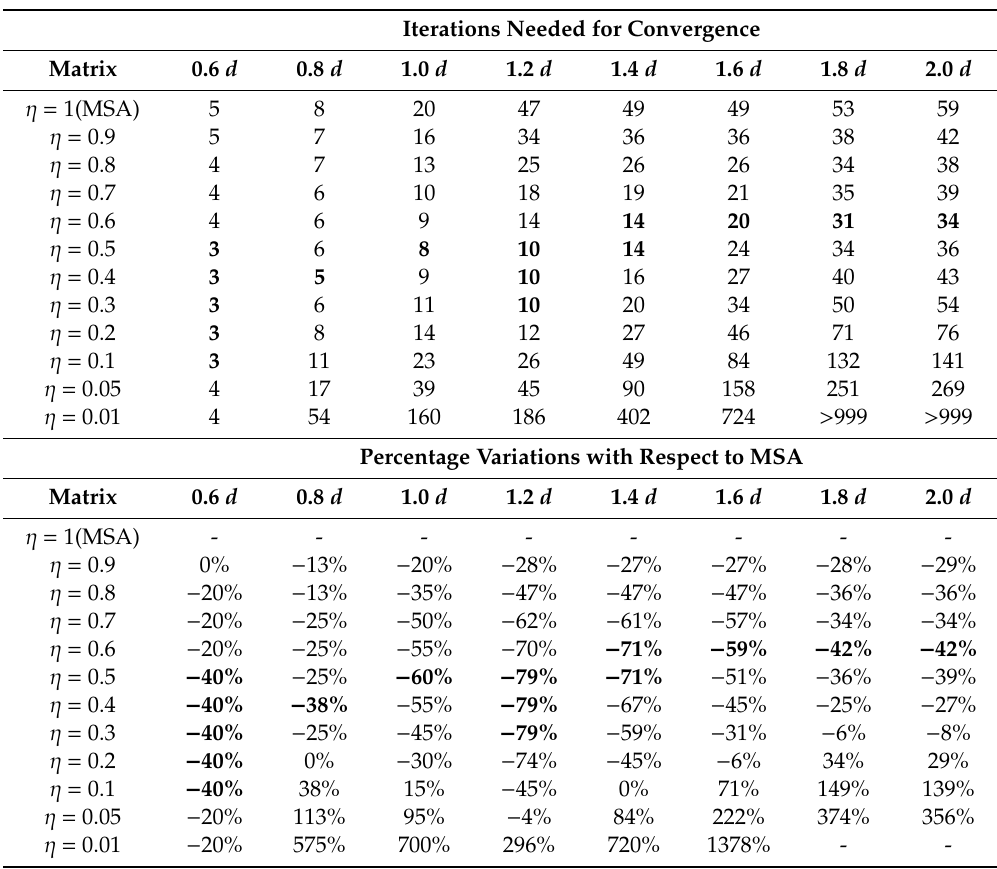
Table 7. Results on the urban real-scale network ( C v = 0.05).